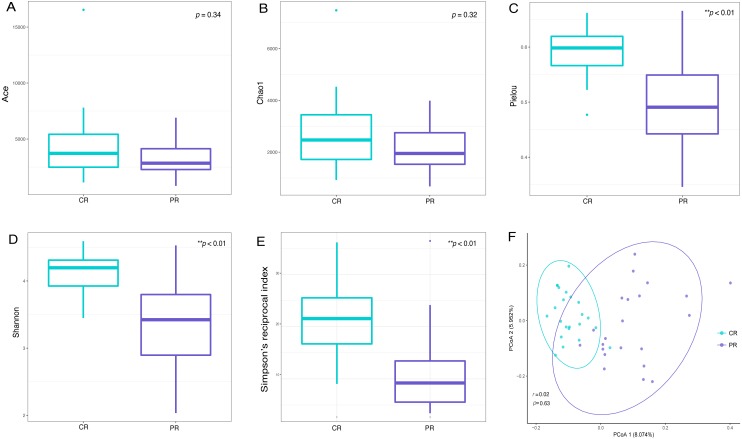
Comparisons of alpha and beta diversity indices between primary Sjögren’s syndrome (pSS) patients and healthy controls.Higher Ace (A), Chao1 (B), Pielou (C), Shannon (D) and Simpson’s reciprocal index (E) indicate higher alpha diversity. Box plots of alpha diversity measure using Pielou (C), Shannon (D) and Simpson’s reciprocal index (E) showed a decrease in diversity in the rinse samples from pSS patients (p < 0.01). (F) Comparison of principal coordinates analysis (PCoA) of primary Sjögren’s syndrome (pSS) patients and healthy controls by using weighted UniFrac distance. Each dot represents one sample and the distance between the samples represents the difference in community composition of the samples. There was no great significance in beta diversity between two groups (p = 0.63). ** p < 0.01, PR, rinse samples of pSS patients; CR, rinse samples of healthy controls.